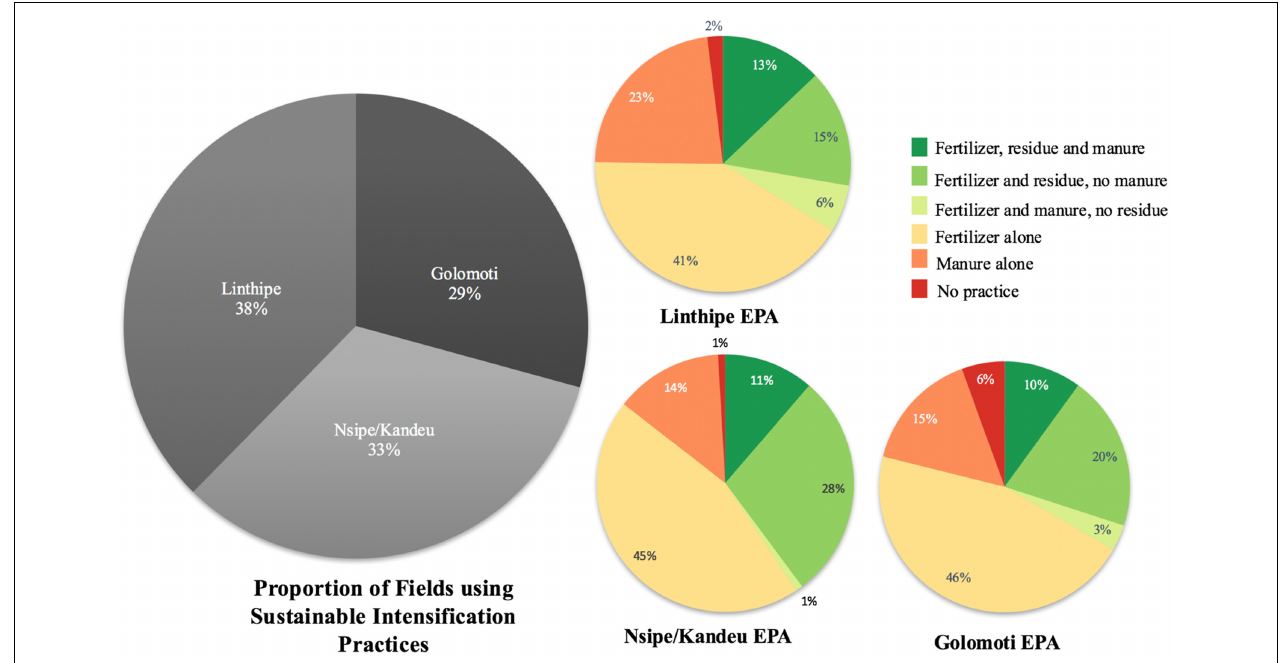
FIGURE 4 | Proportion of area devoted to field management practices is shown in this figure for low (Golomoti), medium (Nsipe and Kandeu), and high (Linthipe) potential sites in Central Malawi based on project survey conducted July of 2013, fields n = 600. The overall pie chart shows